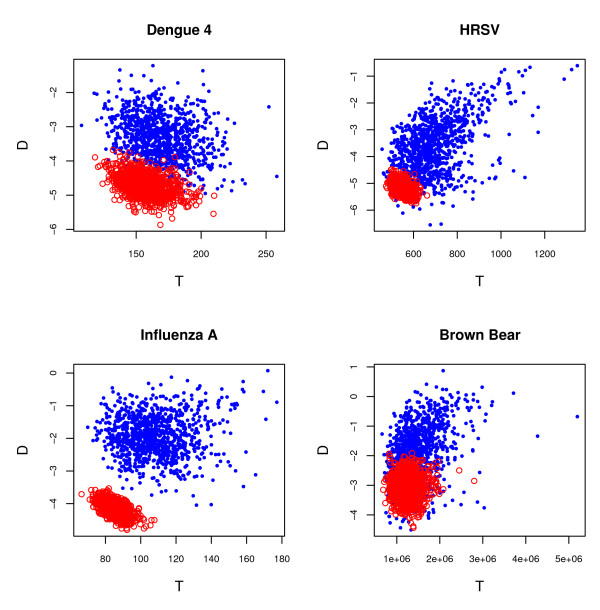
Posterior and predictive distributions of tree length T and DF. Posterior and predictive distributions of tree length T and DF for all four data sets. The dengue-4 data is from an analysis assuming exponential growth, while the other three analyses assumed a constant population size. Human influenza A virus shows the largest departure from neutrality, with the posterior distribution completely disjoint from the predictive distribution.